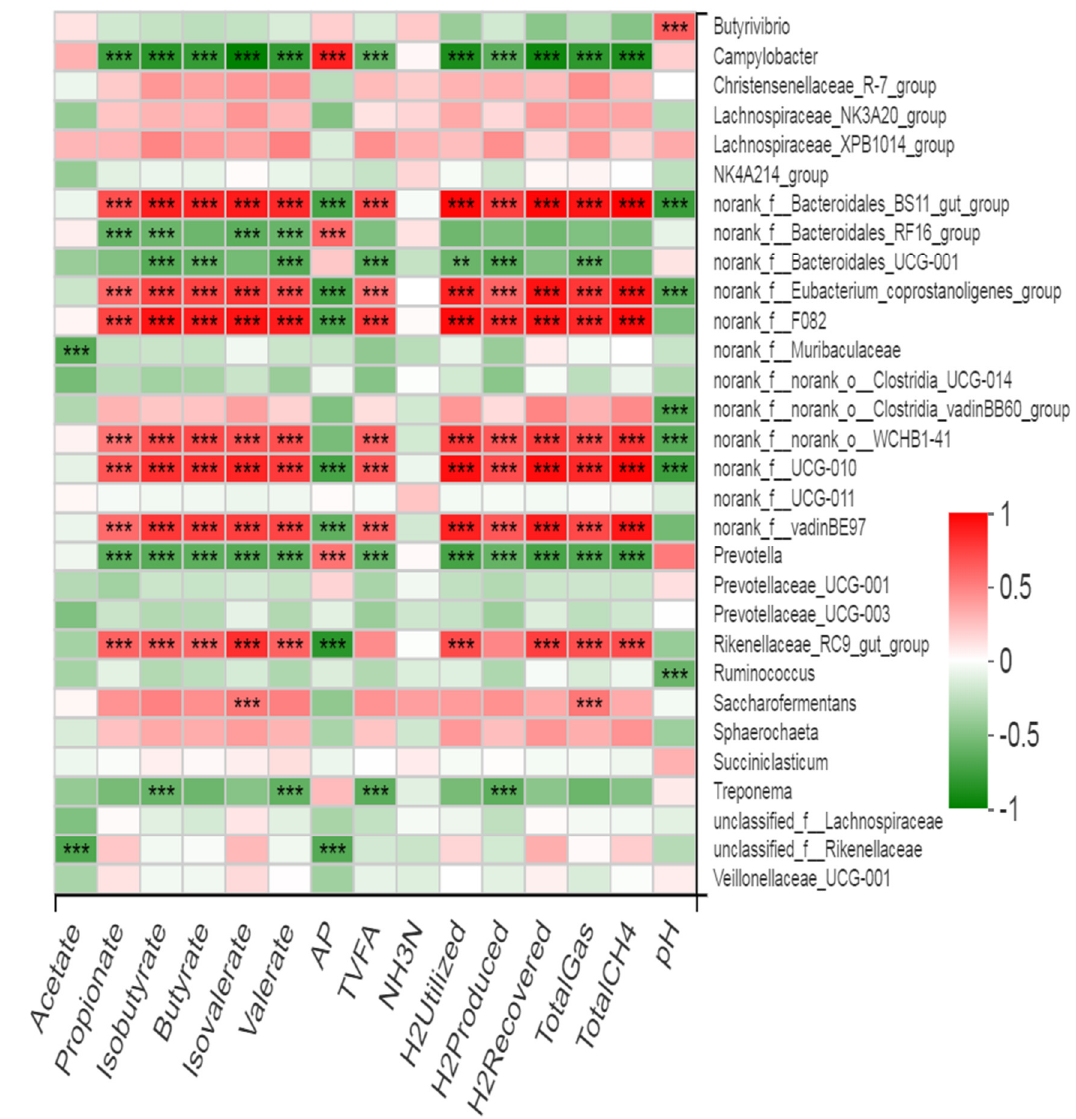
Figure 9. Correlation of bacterial genera with hydrogen balance, total gas, CH 4 , and VFAs.